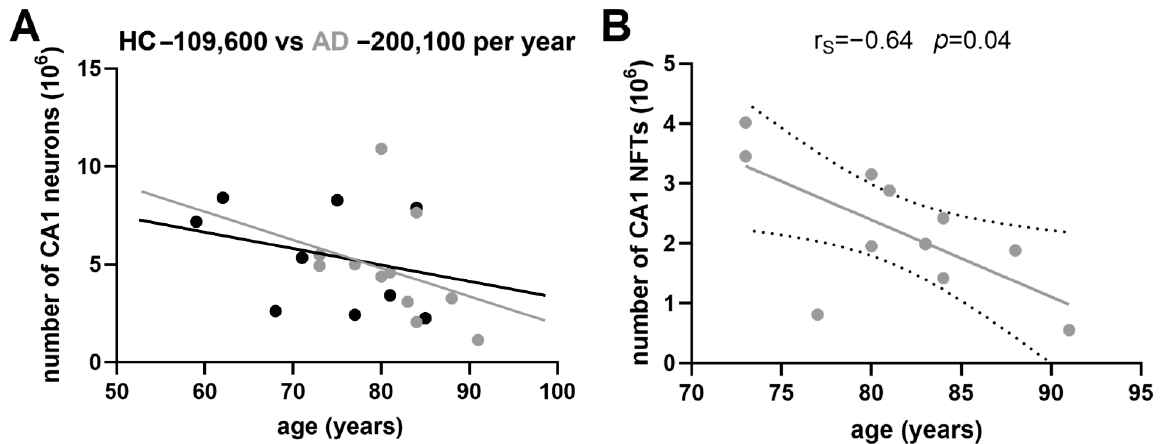
Figure 3. ( A ) Age-related neuronal loss in the CA1 field of HC and AD cases. The average annual difference is 90.5 thousand neurons. ( B ) The age-related number of NFTs negatively correlates with the age of AD subjects in the CA1 field of hippocampal formation. This means that younger AD patients had more neurofibrillary tangles than the older ones. Dotted lines represent the 95% confidence interval.